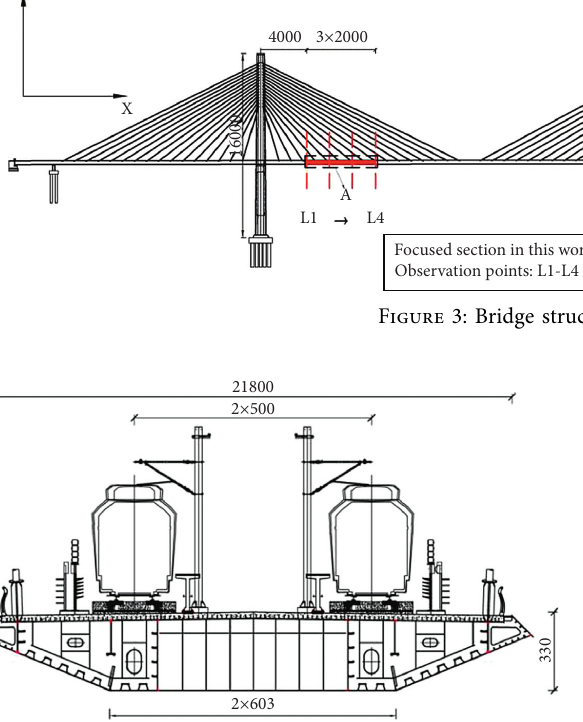
Figure 4: Cross-sectional layout (unit: cm).